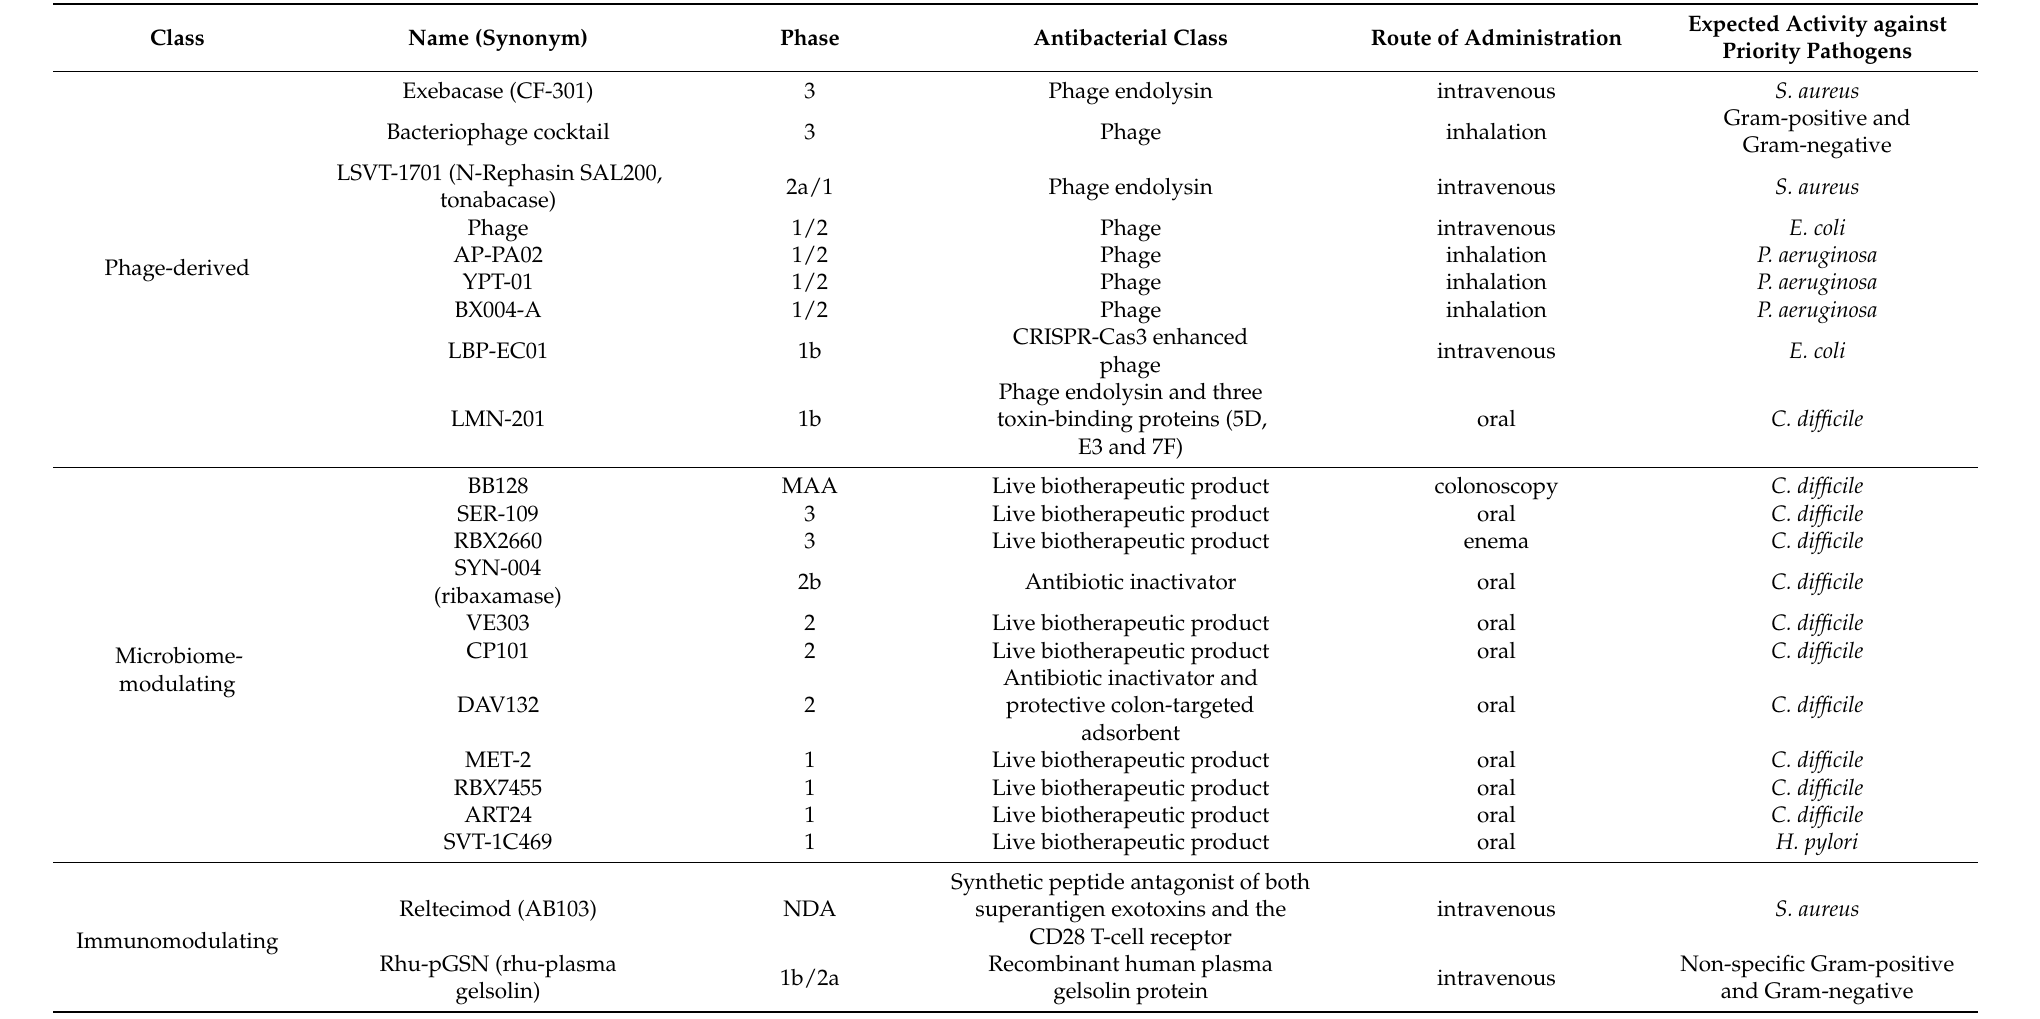
Table 2. Next-generation antibiotics in clinical development according to the WHO analysis (published in 2022). (MAA: market authorization application; NDA: new drug